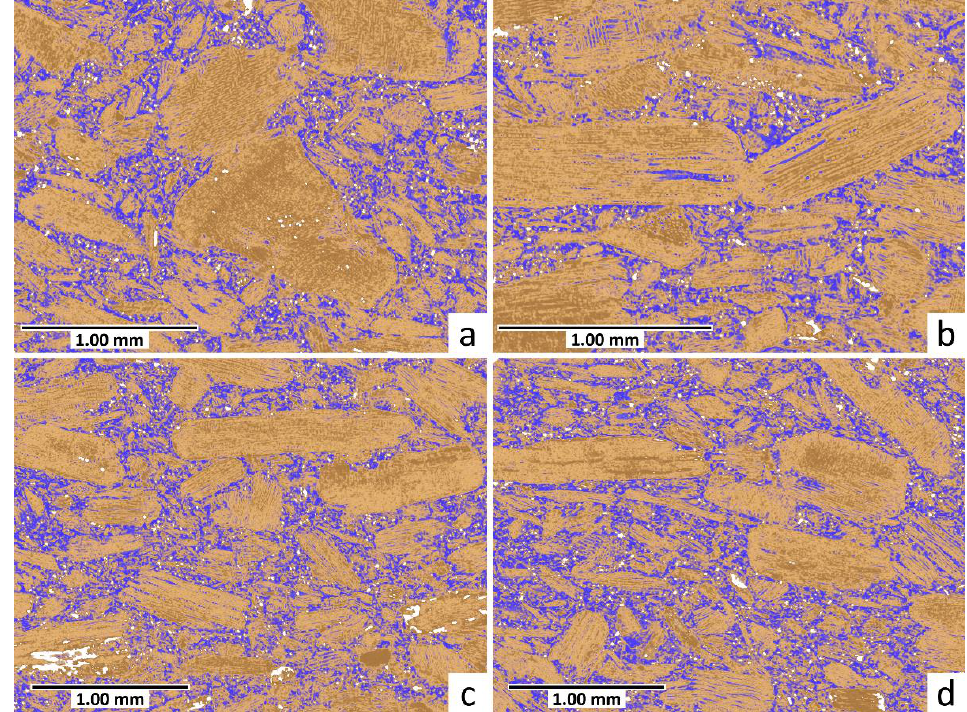
Figure 3. Tomographic images of the wood plastic composite after it was impregnated with sodium iodide showing wood-to-wood connections ( a , b ) and orientation of particles in the sample ( c , d ).